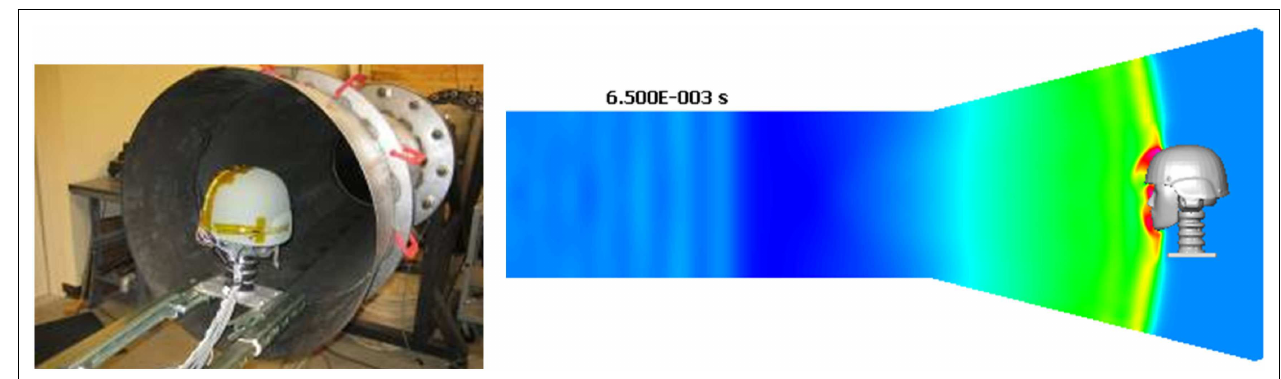
FIGURE 12 |A human head phantom in the shock tube for testing blast wave loading (Przekwas et al., 2011) .